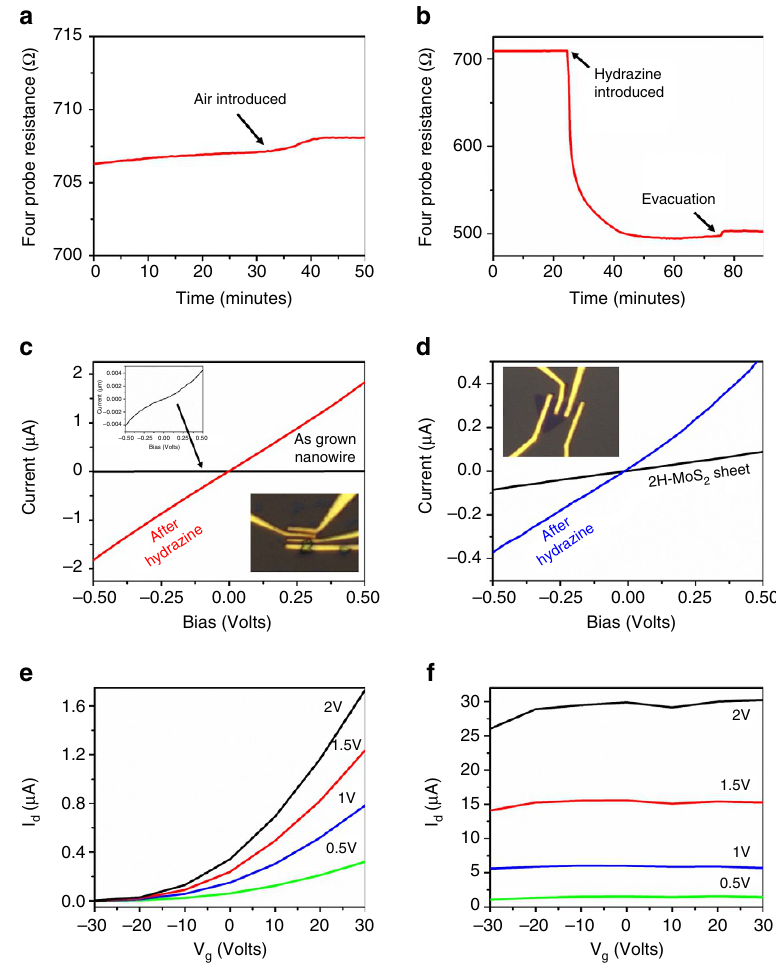
Figure 4 | Effects of hydrazine treatment on conductivity of MoS 2 architectures. ( a ) Four-probe resistance measurement of MoO x /MoS 2 core-shell nanowire array, grown on a non-conductive glass substrate, with exposure to ambient air (shown by arrow) to B 350 Torr. ( b ) The effects on the four-probe resistance of the MoO x /MoS 2 core-shell nanowire array following the introduction of a small amount ( B 15 Torr) of hydrazine (N 2 H 4 ) vapour, leading to an almost instantaneous, and irreversible drop in the system resistance. ( c ) Resistance measurement of device fabricated on a small cluster of MoO x /MoS 2 core-shell nanowires (optical micrograph shown in inset). The resistance of the nanowires decreases from B 133 to 0.3M O following exposure to hydrazine. ( d ) Resistance measurement of device fabricated on single CVD grown 2H-MoS 2 sheet (optical micrograph shown in inset). The resistance decreases from B 5.8 to 1.2M O following exposure to hydrazine. ( e ) Drain current-gate voltage analysis of single CVD grown 2H-MoS 2 sheet and ( f ) following exposure to dilute